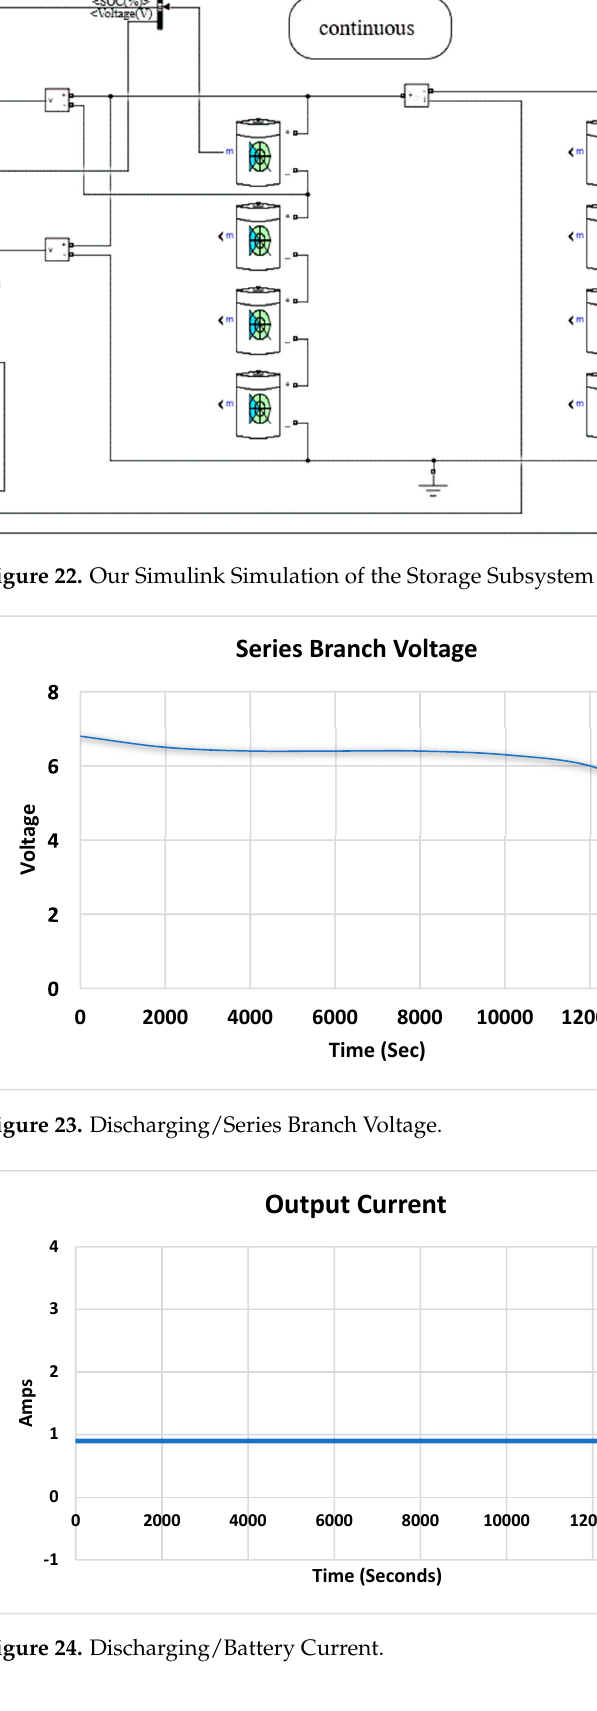
Figure 25. Discharging/Battery Voltage .